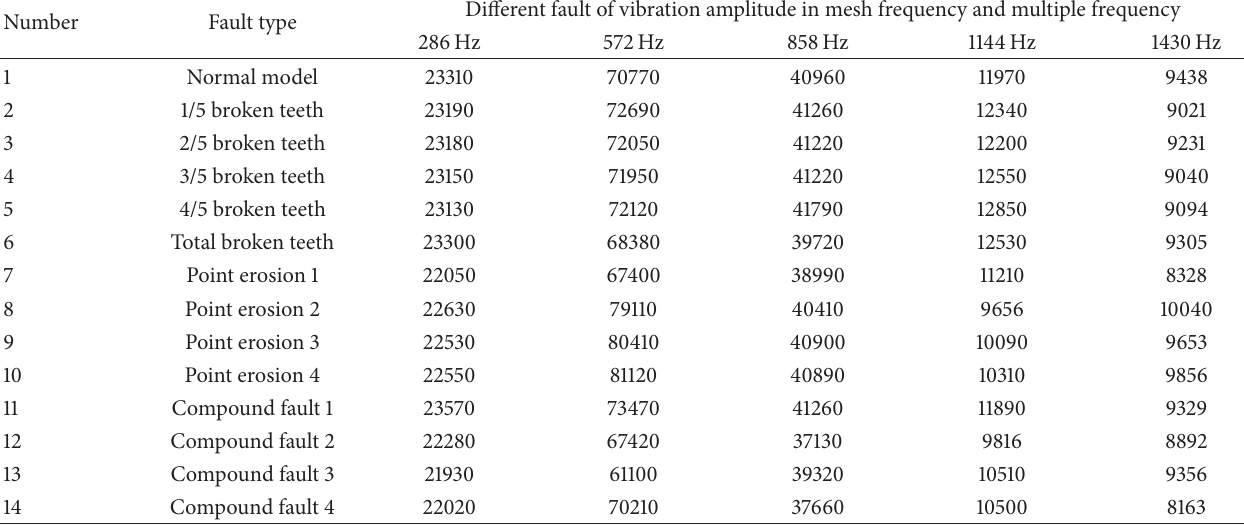
Table 2: The fault simulation data.